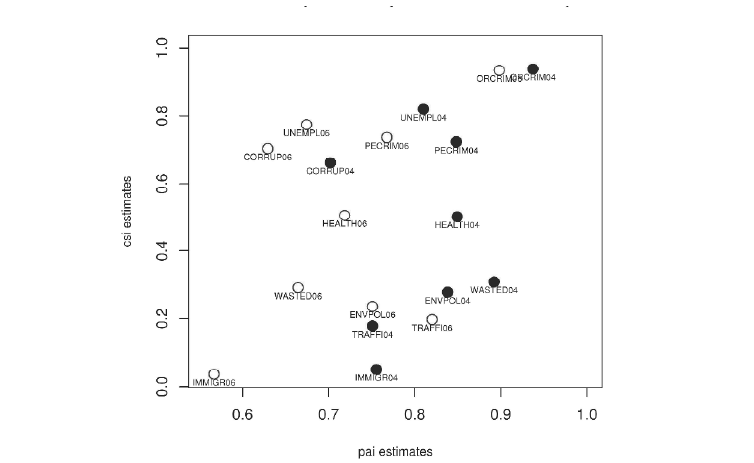
Figure 5 – Estimated CUB models for 2004 ( ) • and 2006 ( ) (cid:68)